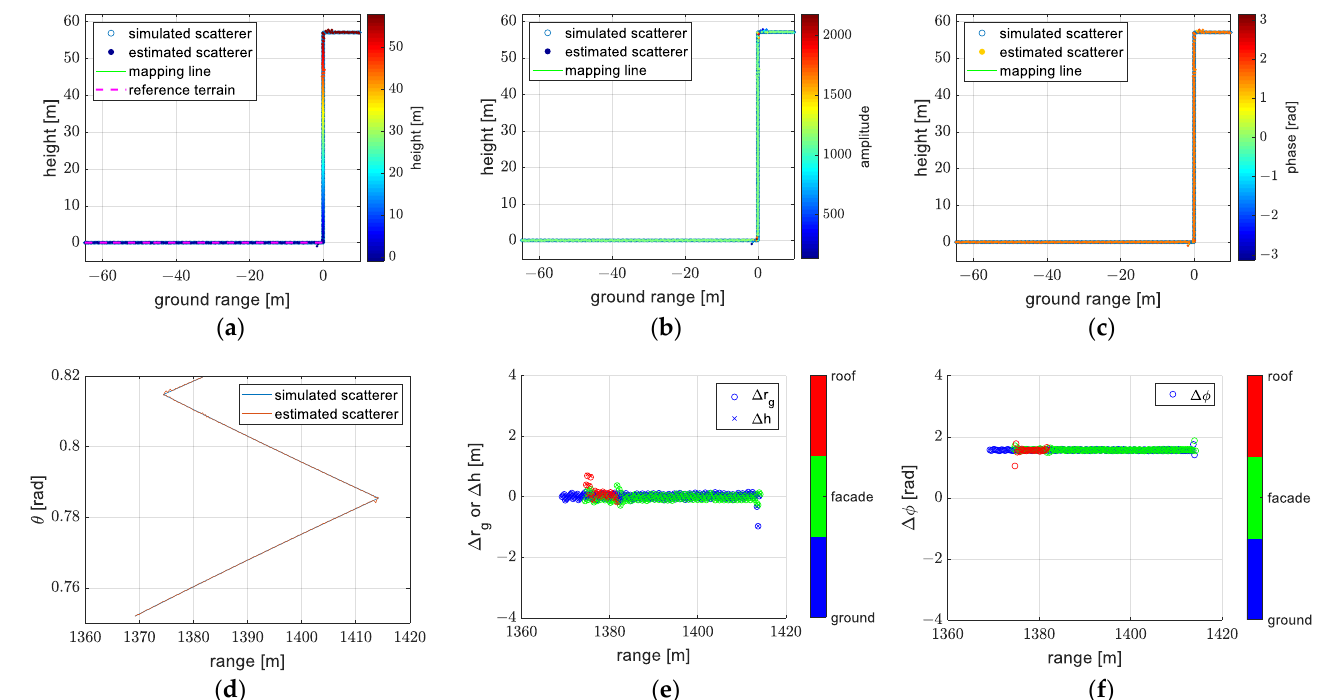
Figure 16. The reconstruction obtained under model 1 (the exact form of the planar wavefront model) after transformation: ( a ) reconstruction with colors denoted as height, ( b ) reconstruction with colors denoted as amplitude, ( c ) reconstruction with colors denoted as phase, ( d ) the off-nadir angle of the reconstruction, ( e ) the error of the ground range and height, ( f ) the error of the phase.